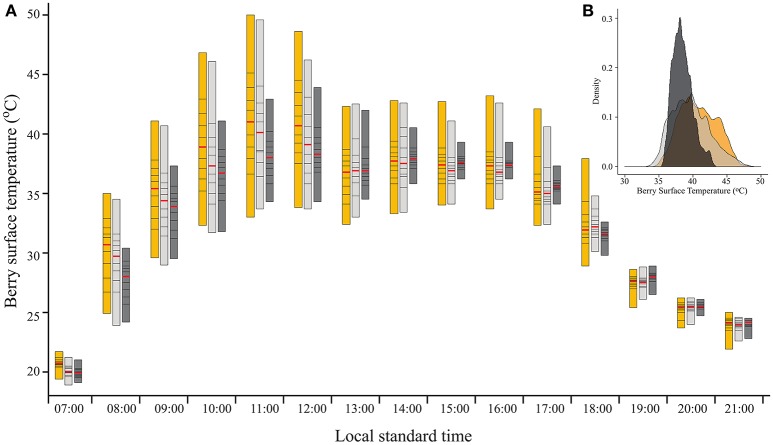
(A) Percentile bars showing the diurnal trend of berry surface temperature, measured on August 19, 2015 on clusters located on the east side of the canopy, subjected to three sunlight exposure levels: fully exposed clusters (exposed), clusters shaded with 30% shading nets (30% shaded) and clusters shaded with 60% shading nets (60% shaded). Red lines highlight the median values. (B) Density plot of the data shown for 11:00.